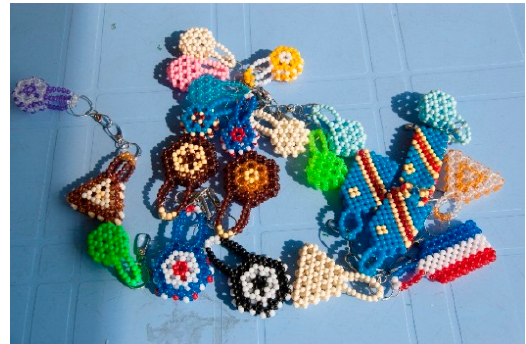
Figure 1. Key rings.